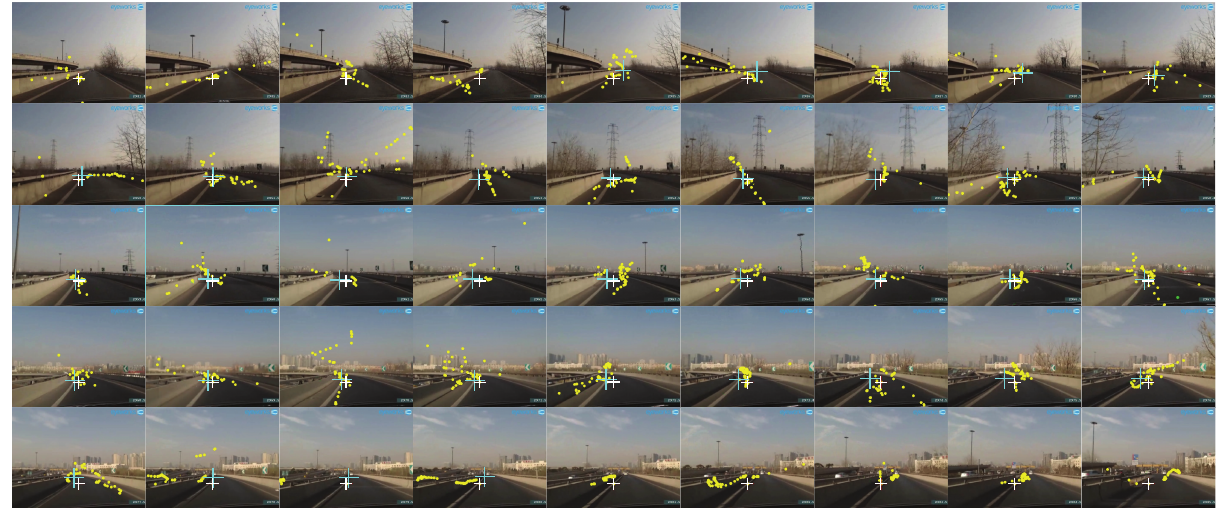
Figure 9: The distribution of fixation points in the left-turning process.